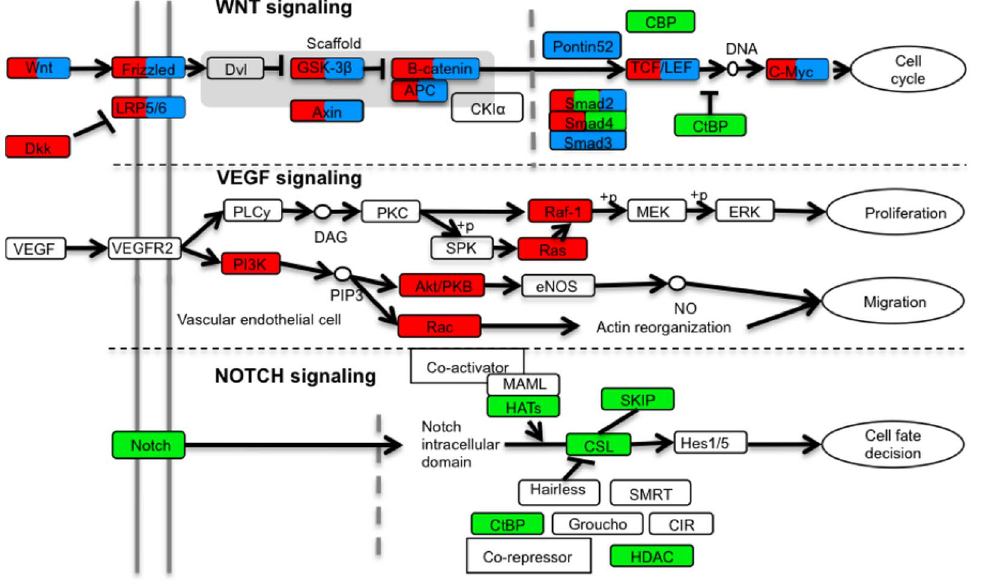
Figure 5. Signaling pathways enriched with upstream driver subnetworks for three CRC subtypes. Wnt, VEFG and Notch signaling pathways from KEGG were simplified. Genes with genomic alterations in subtype 1, 2 and 3 were colored with red, green and blue, separately. Genes with genomic alterations in more than one subtype were given multiple colors.